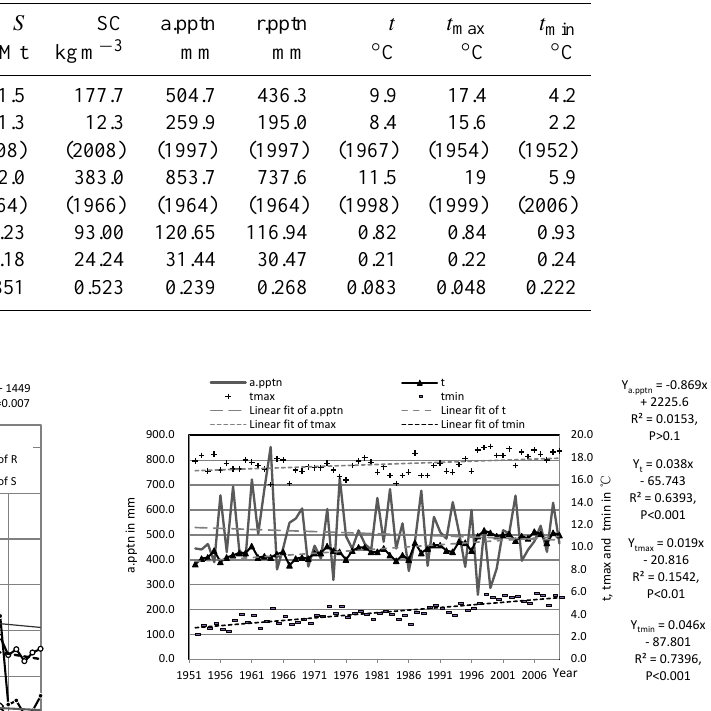
Fig. 3. Annual precipitation and temperature change in 1952-2010 2 3